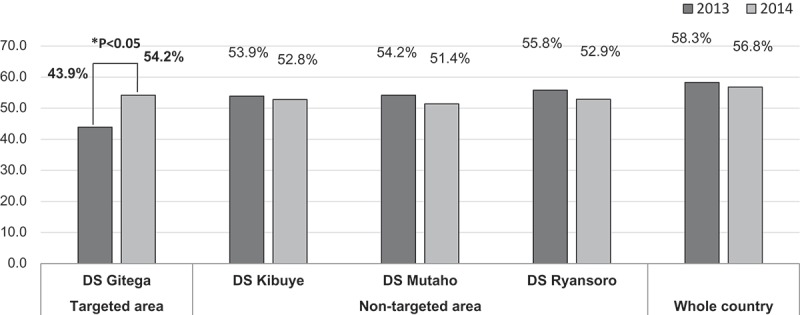
Annual PNC coverage changes from 2013 [14] to 2014 [15] by targeted and non-targeted areas among four Districts (D.S) in the Gitega Province and whole country.